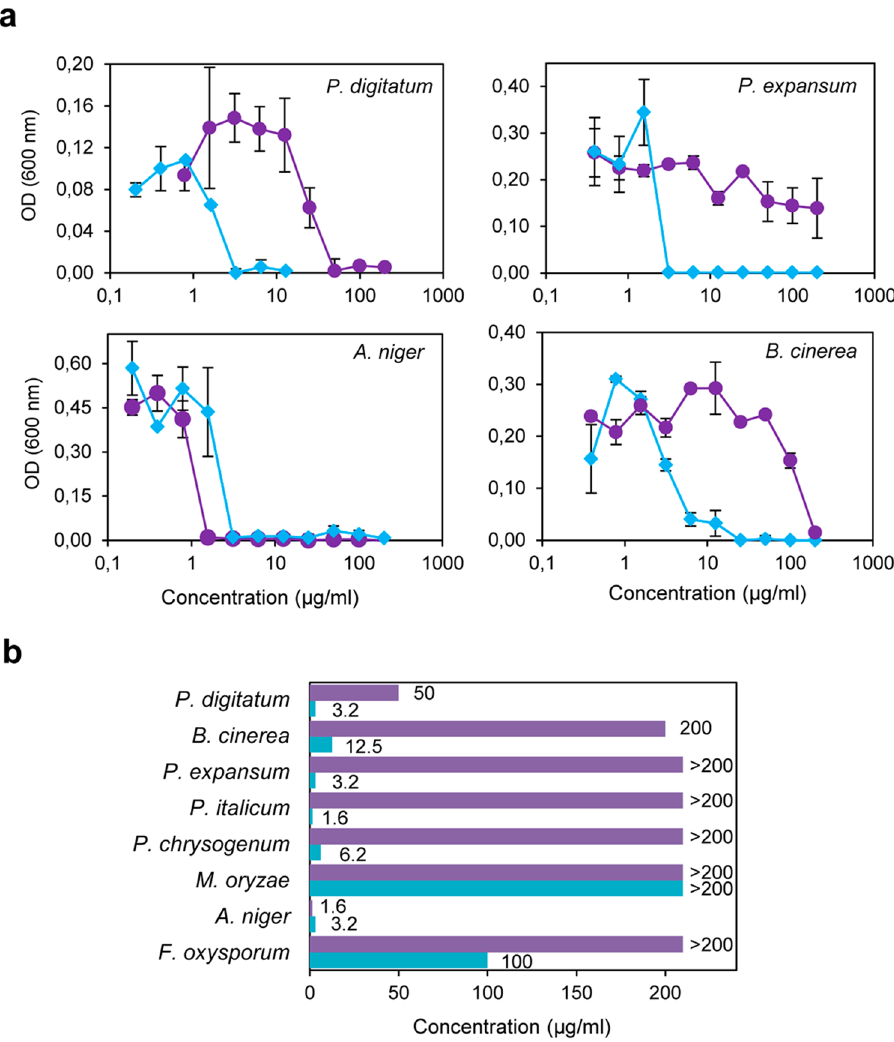
Figure 6. In vitro inhibitory activity of AfpB and PAF against filamentous fungi. ( a ) Dose-response curves comparing the antifungal activity of PAF (purple circles) and AfpB (blue diamonds) against P . digitatum , P . expansum , A . niger , and B . cinerea . Dose-response curves show mean ± s.d. OD 600 of triplicate samples after 72 h of static incubation at 25 °C, except for A . niger , which was incubated at 37 °C. ( b ) MIC values ( µ g/ml) of AfpB and PAF against all the fungi